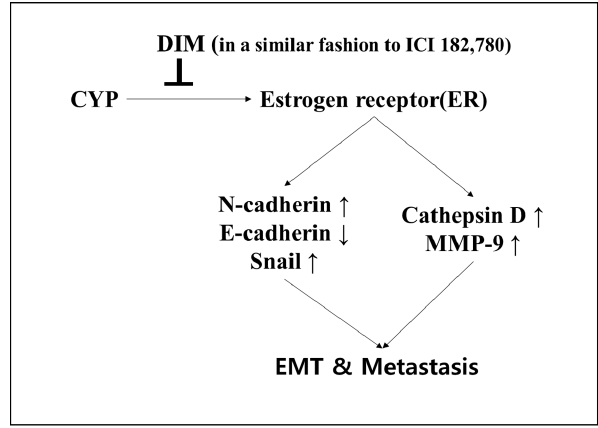
Figure 7. Suppressive behaviors of DIM on E2- or CYP-induced EMT and metastasis of Ishikawa cells. CYP was presented by acting as xenoestrogens via acceleration of the proliferation of estrogen-responsive Ishikawa endometrial cancer cells. CYP also enhanced EMT, migration, and invasion of Ishikawa cells by regulating EMT-related genes, such as E-cadherin , N-cadherin , and Snail , as well as metastasis-related genes, including Cathepsin D and MMP-9 in an ER-dependent manner, as did E2. Conversely, DIM was found to significantly suppress E2 and CYP-induced proliferation, EMT, migration, and invasion of Ishikawa cancer cells, implying that while CYP has the capacity to enhance the metastatic potential of estrogen-responsive endometrial cancer, DIM has CYP ( ⊥ ; decrease or inhibit, arrows; increase or promote).